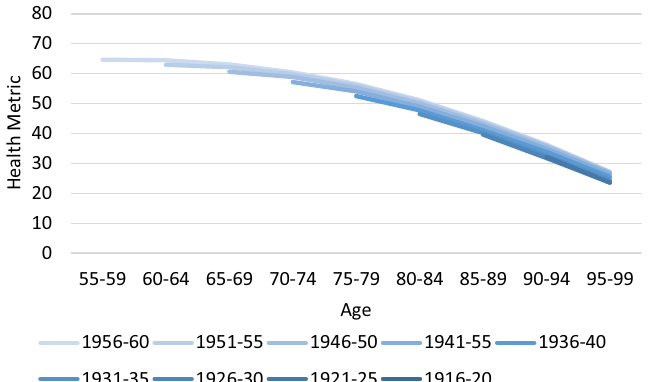
Figure 2. Projected average health metric by cohort over the period 2015–2060, under baseline